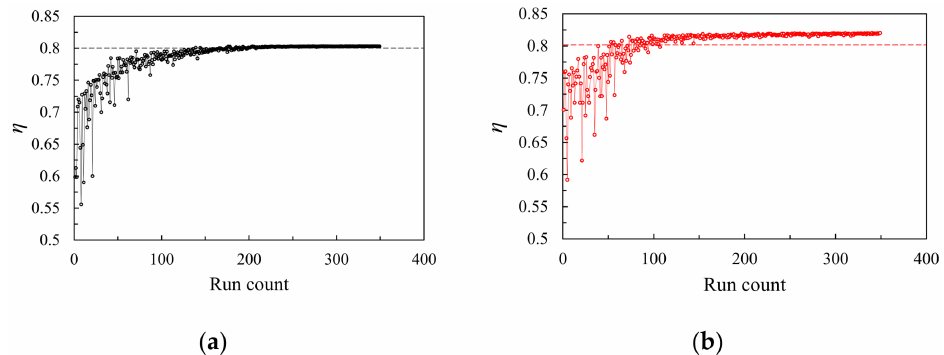
Figure 16. Convergence history of two optimized propellers in the optimization of chord and pitch distribution: ( a ) Prop A; ( b ) Prop